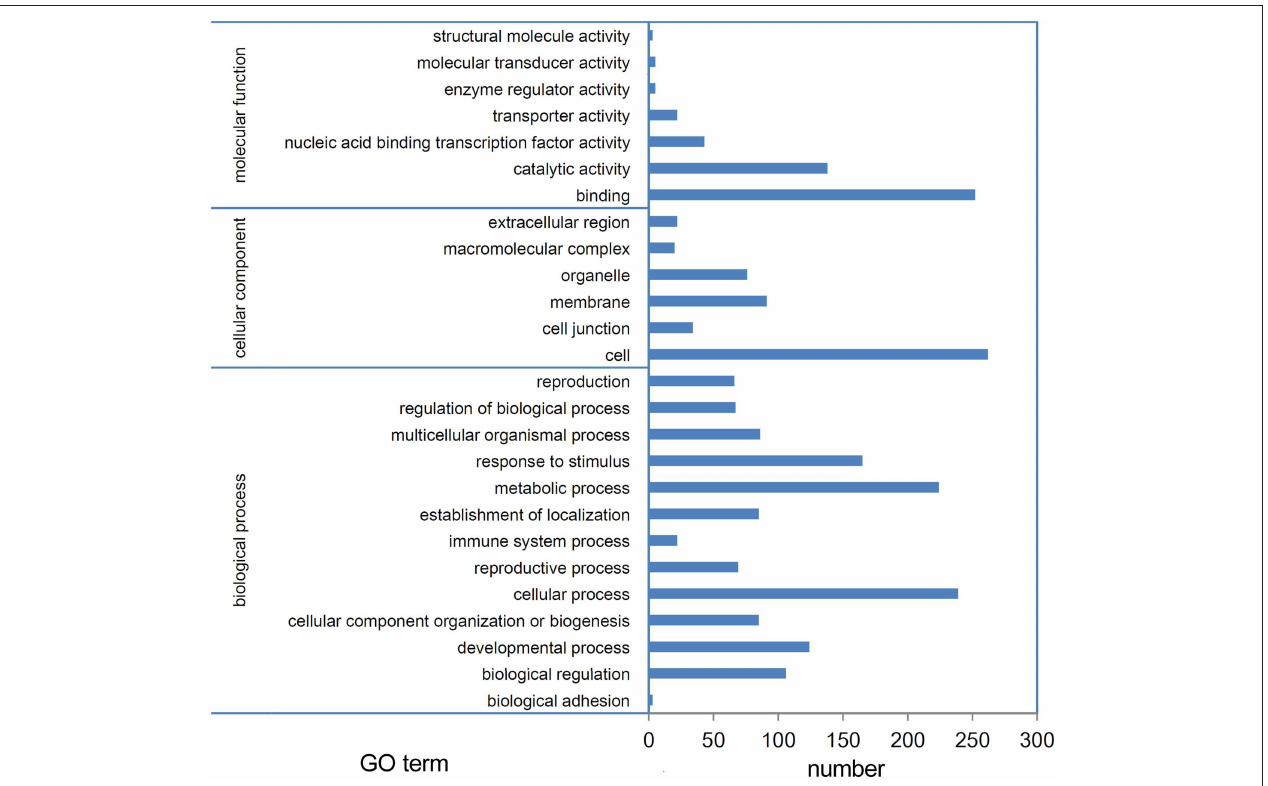
FIGURE 4 | GO annotation of targets. Targets of miRNAs expressed in Tyms and 231-330 Chinese cabbage buds were detected by degradome sequencing